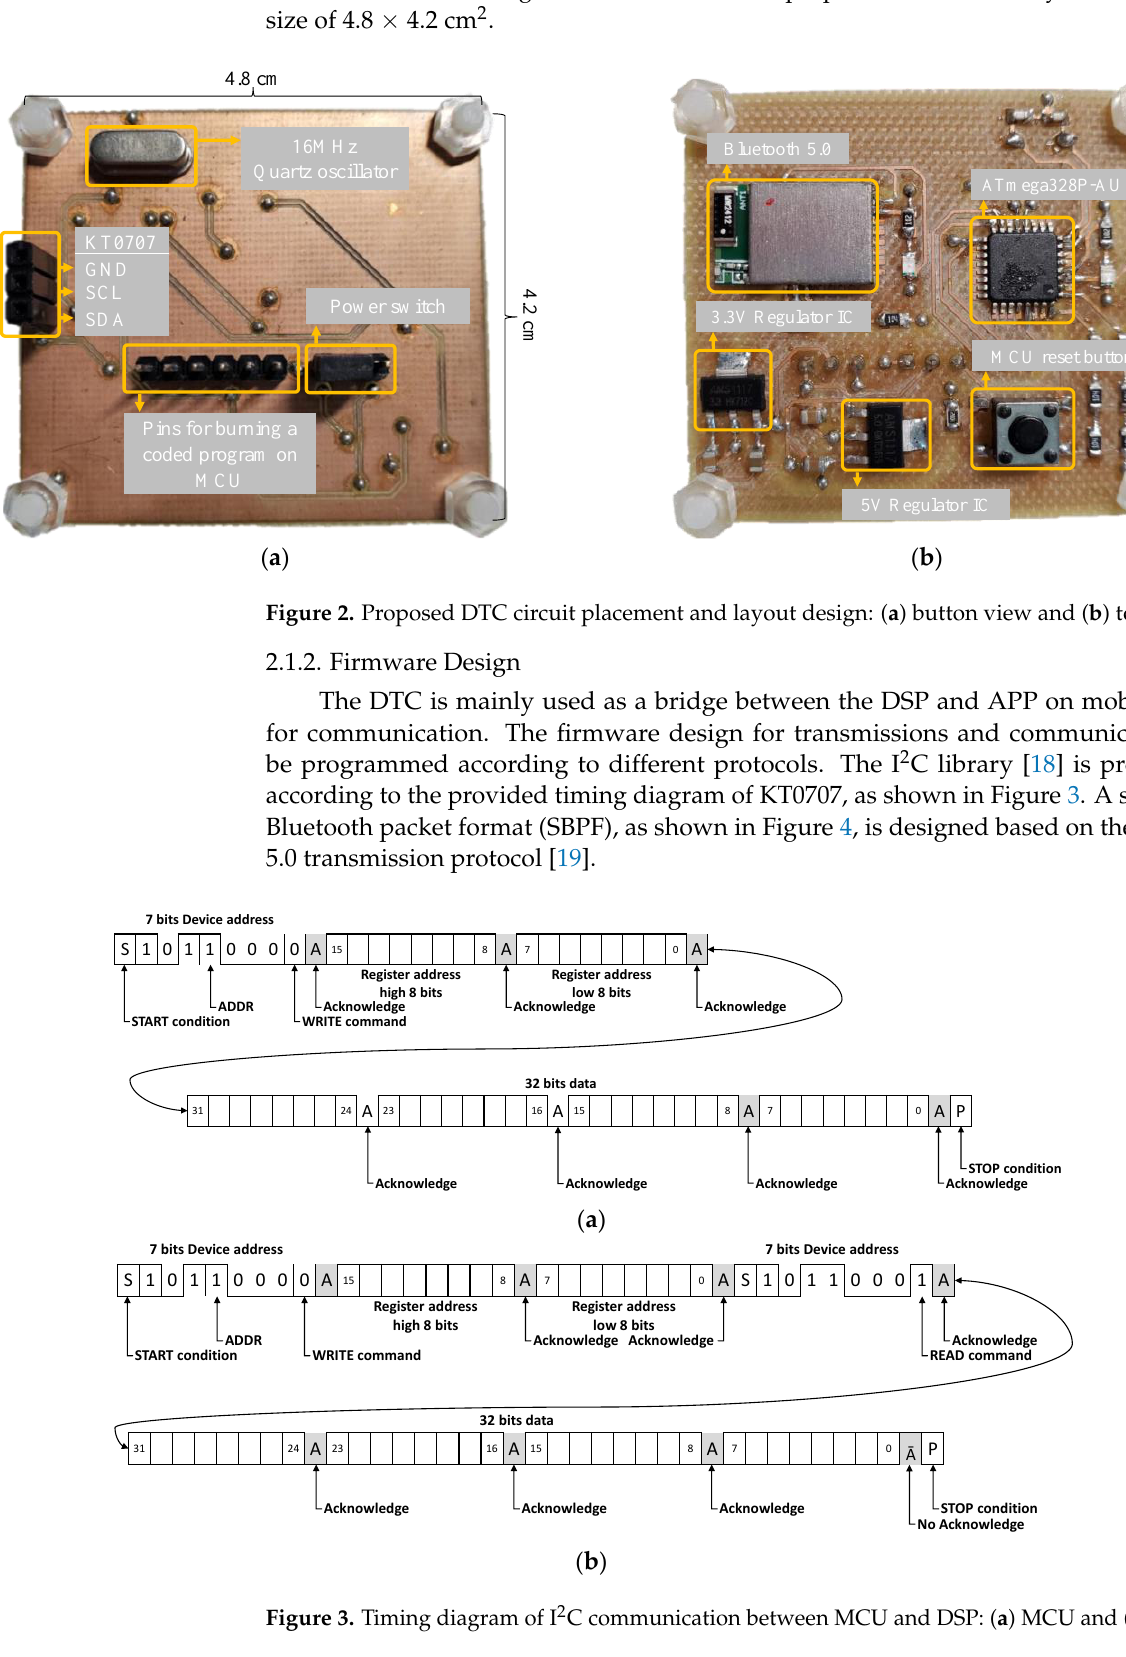
( a ) ( b ) Figure 4. The proposed self-defined Bluetooth packet format and ACK mechanism: ( a ) SBPF and ( b ) schematic diagram of the handshake of the ACK mechanism. The control commands of DSP, including the register names, values, and features are partially listed in Table 2. The proposed smart system platform mainly contains the fol- lowing functions: (1) switches of volume control for four input sources, (2) switch of equal- ization (EQ; low, middle, and high frequency) and the gain adjustments for four input sources, and (3) reverberation processing of two input sources. The reverberation adjustment is divided into the following two parts: (1) Reverbera- tion of room size, which will simulate the room size of the space where the analog sound made is located. The smaller value represents the smaller room. (2) The reverberation level